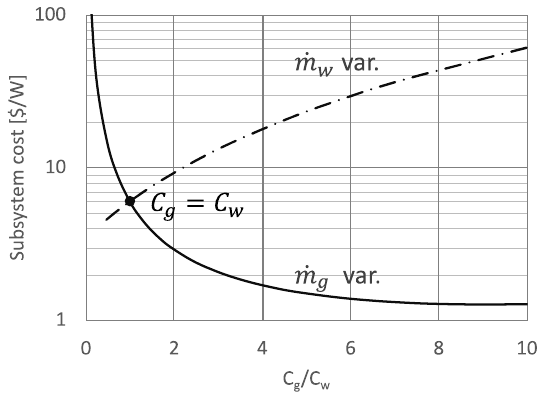
Figure 13. Subsystem material cost ($/W) vs flow rate. The flow rate of either the hot gas ( 𝑚(cid:4662) (cid:3034) ) or the cold water ( 𝑚(cid:4662) (cid:3050) ) is variable. The cost contains the materials needed to make the substructure system. In particular, the thermoelectric material cost ($500/kg) is a major factor. This calculation assumes an aggressively small fill factor of 10%.